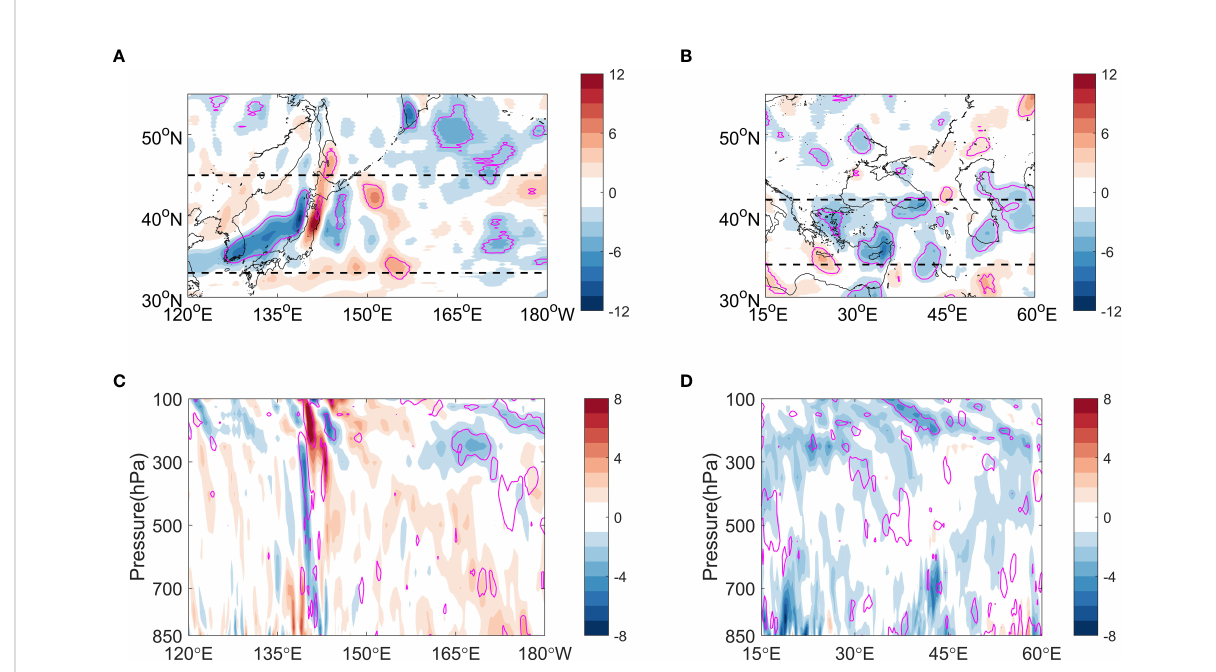
FIGURE 6 The lagged regressions of 300-hPa RWS (shading; unit, 10 − 11 s − 2 ) over the (A) KE and (B) MedT regions in DJF onto the KEI 2 months earlier. The corresponding vertical pro fi les of RWS responses along the meridional average are plotted in panels (C, D) respectively, with dashed lines in panels ( A, B ) marking the regions used for calculating the meridional average. Magenta contours are signi fi cant at the 90% con fi dence level. RWS, Rossby wave source; KE, Kuroshio Extension; MedT, Mediterranean trough; KEI, Kuroshio Extension index.